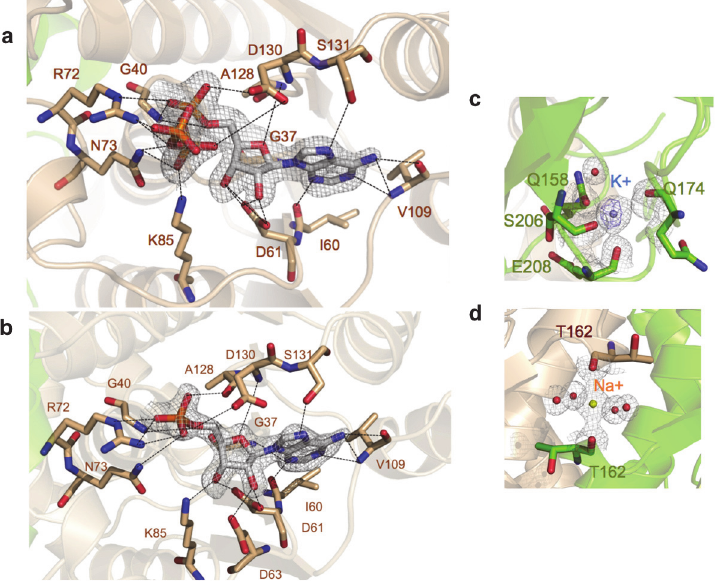
Fig 3. X-ray electron density maps of the ATP- and AMP-binding pocket and metal coordination spheres. a Detailed view of the ATP-binding site of TcdA. Residues that interact with ATP are labeled and shown as sticks and atom colors (C atoms are in subunit colors, as in Fig. 1). 2mF o -DF c electron density map is depicted around the ATP substrate at 1.5 σ contour level. b Detailed view of AMP bound in the active site. Representation and electron density map as in ( a ). c , d Metal coordination spheres of K + ( c ) and Na+ ( d ) cations. Interacting residues are labeled and shown as sticks in atom colors (C atoms are in subunit colors), and coordinating water molecules are shown as red spheres. Metals and their coordination spheres are shown in 2mF o -DF c electron density (grey). The anomalous Fourier map calculated from a long wavelength (1.89 Å ) dataset at 2.4- Å resolution is shown for K + ( c ) in purple; in contrast, Na + has no anomalous signal at that wavelength, enabling the accurate discrimination between K + and Na + cations in the structure.